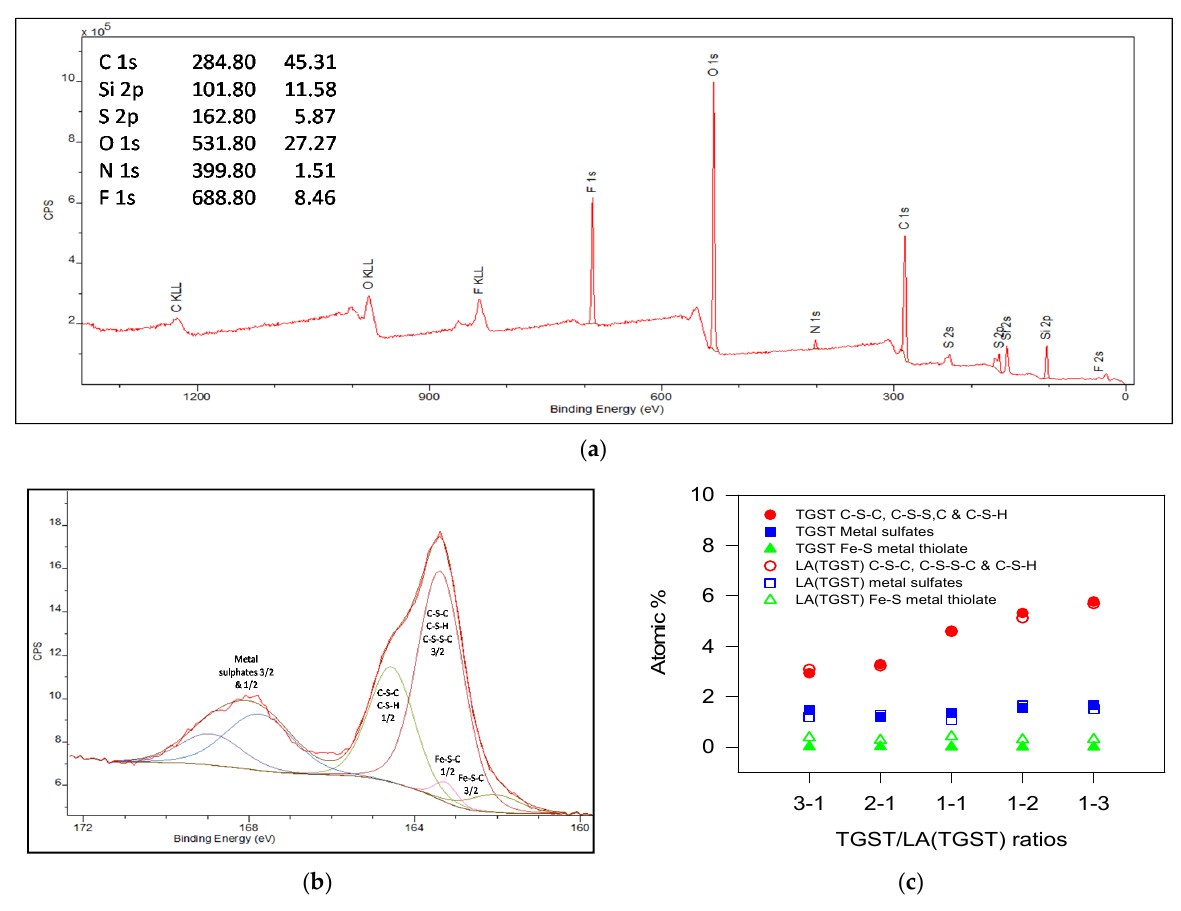
Figure 4. XPS spectra and correlation data for the 3:1 to 1:3 LA(TGST) and TGST ratios. ( a ) Survey scan for 1:1 TGST, ( b ) S2p peak deconvolution spectra for the various sulfur species in TGST 2:1, and ( c ) extent of crosslinking as a function of sulfur concentration.